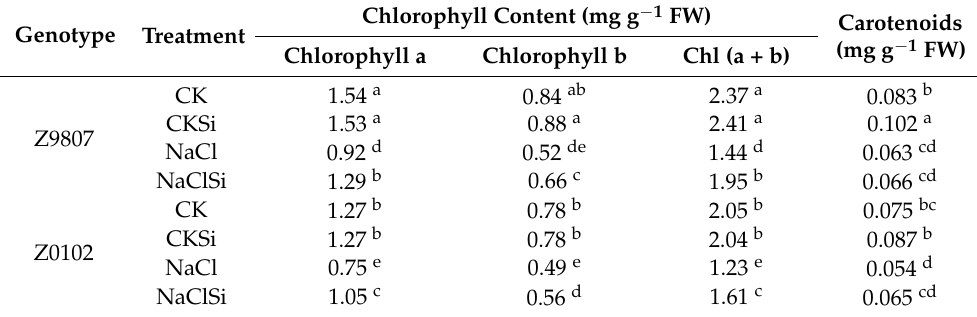
Table 2. Effects of Si on photosynthetic pigments of cotton leaf under saline and non-saline conditions.